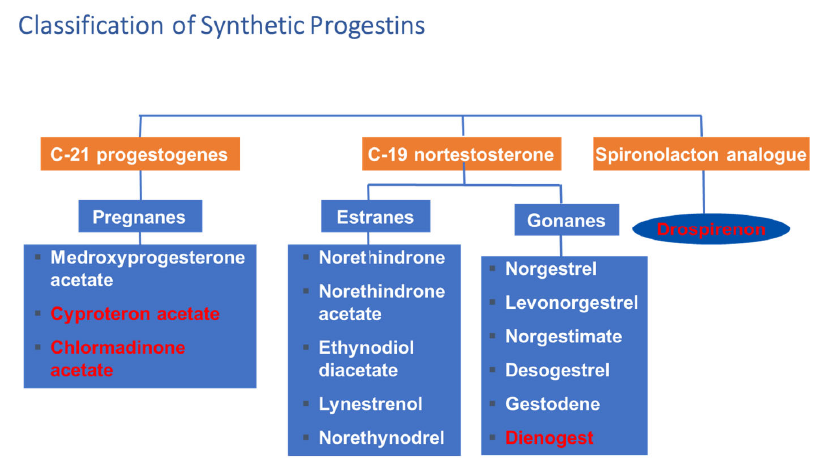
Figure 3. Classification of synthetic progestins. Red color indicates antiandrogenic effect.